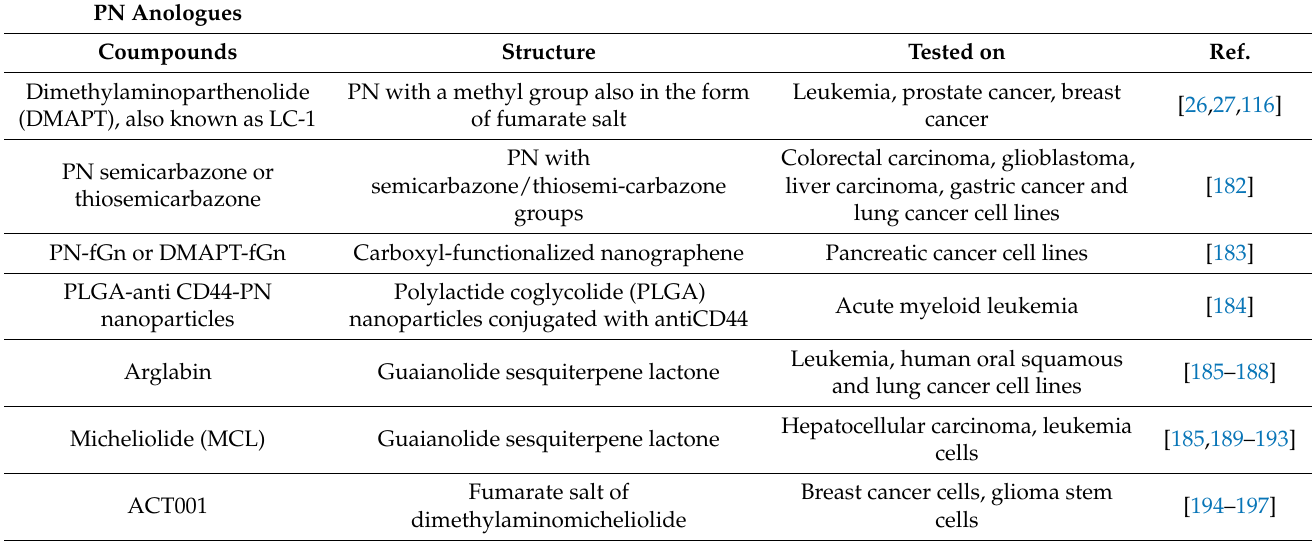
Table 2. Main compounds with structural and functional analogy to